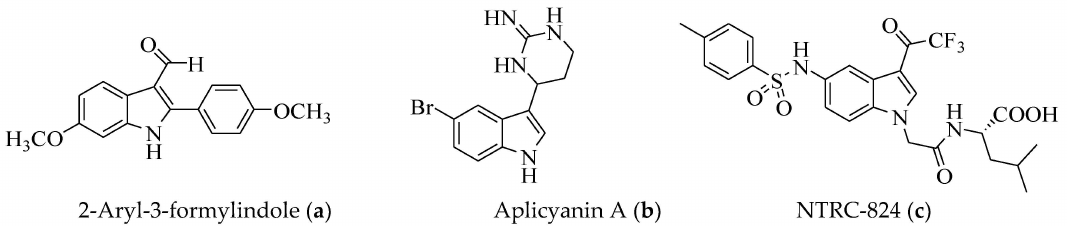
Figure 1. Structures of 3-formyl substituted 2-arylindole ( a ), aplicyanin A ( b ) and NTRC-824 ( c